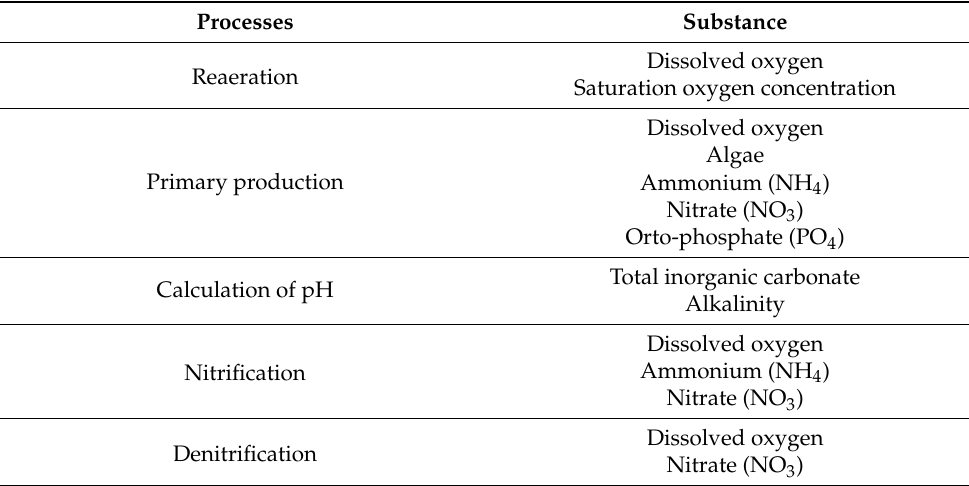
Table 1. Processes and substances used in Delft3D-WAQ